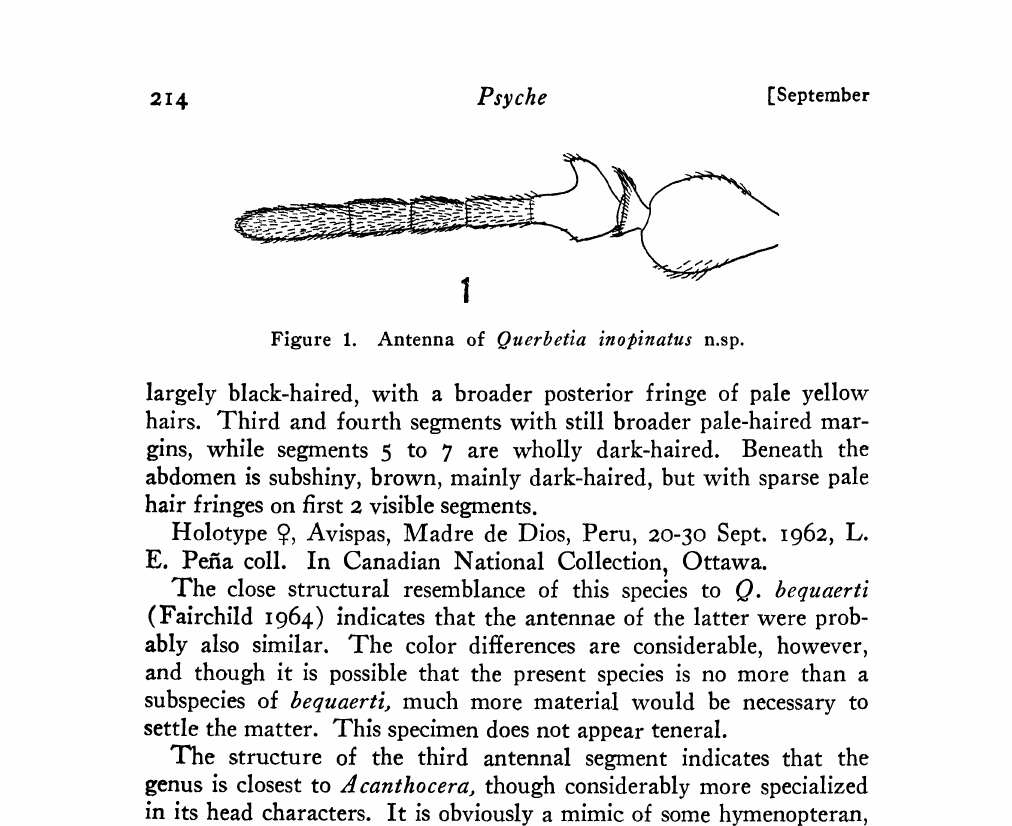
REFEIEIE8 figs. (1963)